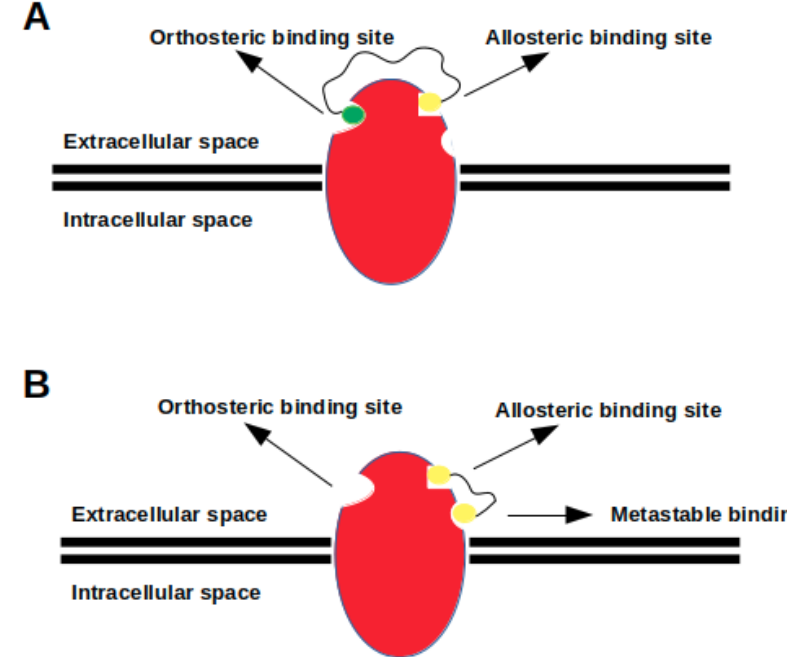
Figure 4. ( A ) a heterobivalent ligand, which is composed of two distinct pharmacophore groups (yellow and green beads) connected by a linker, targets both orthosteric and allosteric binding site simultaneously; ( B ) a homobivalent ligand, which consists of two identical pharmacophore groups (two yellow beads) linked by a proper linker, targets both allosteric and metastable binding sites